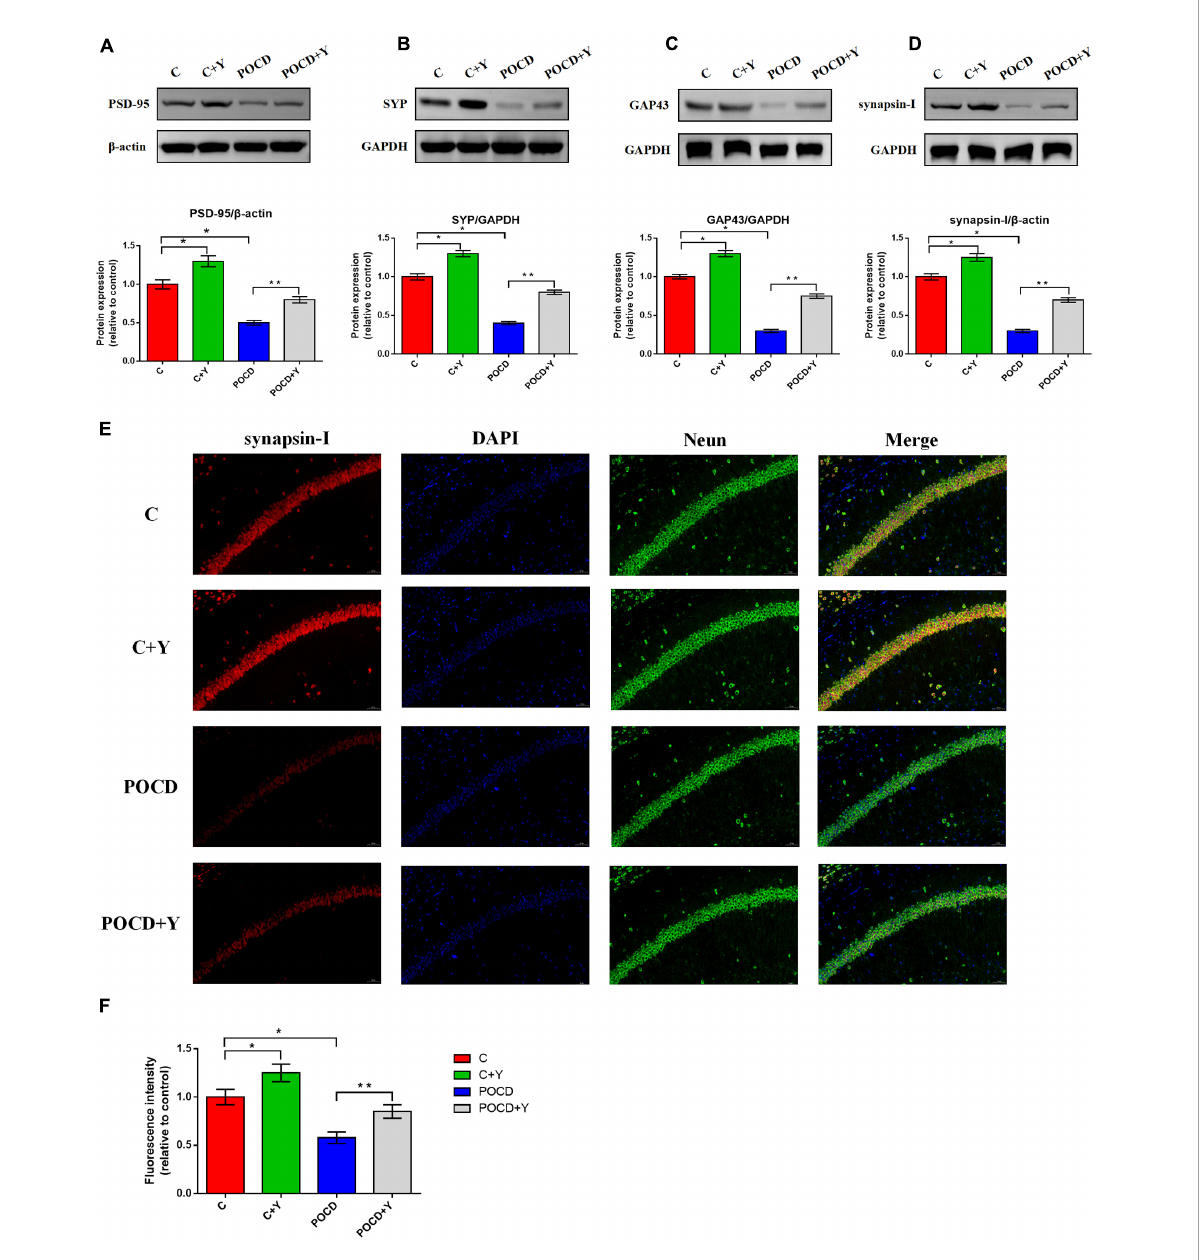
FIGURE7 Young plasma increased the synapse-associated protein expression in postoperative cognitive dysfunction (POCD) rats. The expression of synapse-associated proteins including (A) PSD-95, (B) SYP, (C) GAP-43 and (D) synapsin-I. (E) Representative immunostaining showing the colocalization of Neun (green), synapsin-I (red), and DAPI (blue) in the hippocampus of CA1. Scale bar: 200 µ m. (F) Bar graph summarizing the fluorescence intensity of synapsin-I in the hippocampal CA1. Data are shown as means ± standard deviations. * p < 0.05 compared with group C, ** p < 0.05 compared with group POCD ( n = 7 per